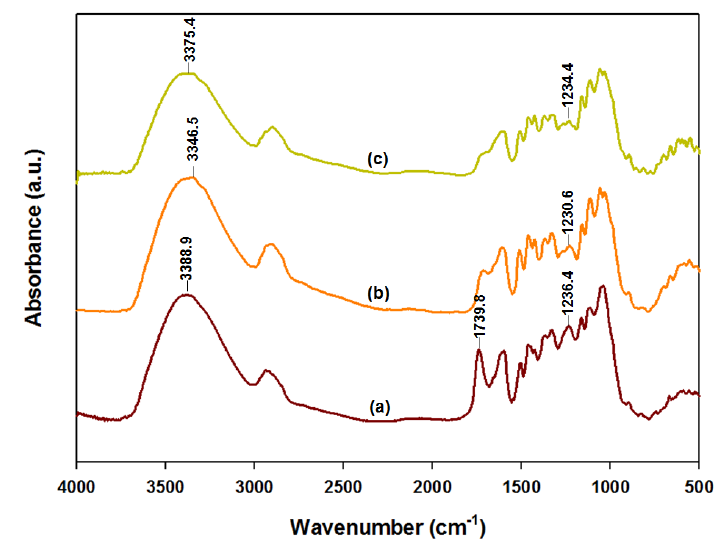
Figure 4. FTIR spectra for the dried Eucalyptus samples, before and after ALEW, as follows: (a) untreated control, (b) air drying (AD) after ALEW, and (c) critical point drying (CPD) after ALEW.